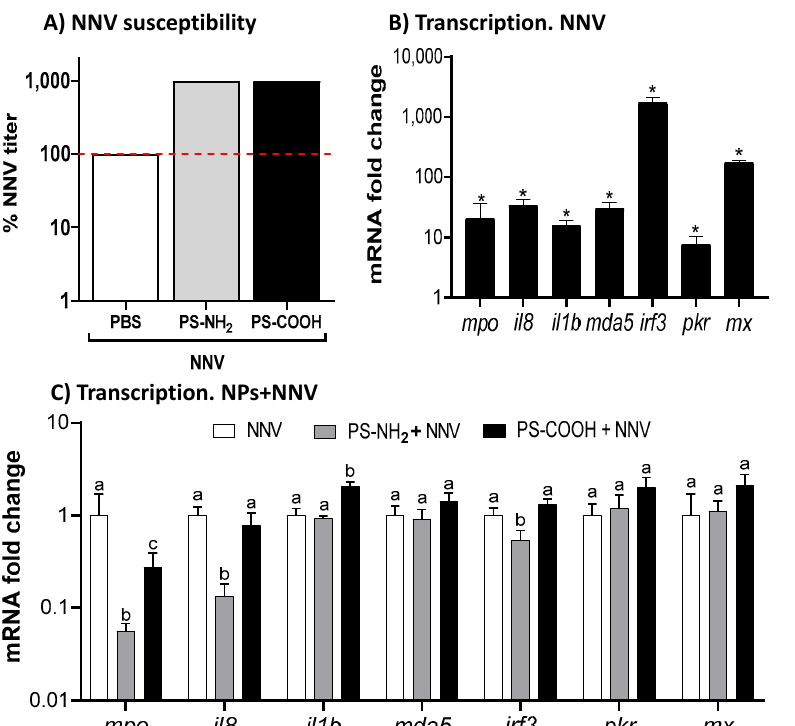
Figure 1. Exposure to functionalized polystyrene nanoplastics (NPs) promotes viral susceptibility but slightly alters the transcriptional profile. ( A ) Percentage of nodavirus (NNV) titer in SaB-1 cells exposed to 1 µ g mL − 1 of 50 nm functionalized polystyrene NPs (PS-NH 2 and PS-COOH) for 24 h and then infected with NNV. The viral titer was determined after 10 days of infection, and the percentage of viral titer with respect to NP-unexposed (PBS) and NNV-infected cells was calculated. Red line indicates 100% of mortality with NNV treatment. ( B ) Transcriptional profile of SaB-1 cells infected with NNV for 24 h. Transcription is presented as the mean mRNA fold-change of the relative gene expression compared to mock-infected cells ± SEM ( n = 3). Asterisks indicate significant differences between NNV- and mock-infected SaB-1 cells (Student- t test; p < 0.05). Values higher than 1 indicate up-regulation due to NNV infection. ( C ) Transcriptional profile of SaB-1cells pre-exposed to 1 μ g mL − 1 of PS-NH 2 and PS-COOH for 24 h and then infected with NNV for 24 h. Transcription is presented as the mean mRNA fold-change of the relative gene expression compared to NNV- infected cells ± SEM ( n = 3). Lowercase letters denote significant differences between NP-exposed and NNV-infected compared to NNV-infected cells (ANOVA and Tukey’s post-hoc tests; p < 0.05). Values higher than 1 indicate up-regulation due to NP exposure whilst those lower than 1 indicate down-regulation. ANOVA, analysis of the variance; mpo , myeloperoxidase; il8 , interleukin 8; il1b , interleukin 1 β ; mda5 , melanoma differentiation-associated gene 5; irf3 , interferon regulatory factor 3; pkr , dsRNA-dependent protein kinase receptor; and mx , myxovirus (influenza) resistance protein.